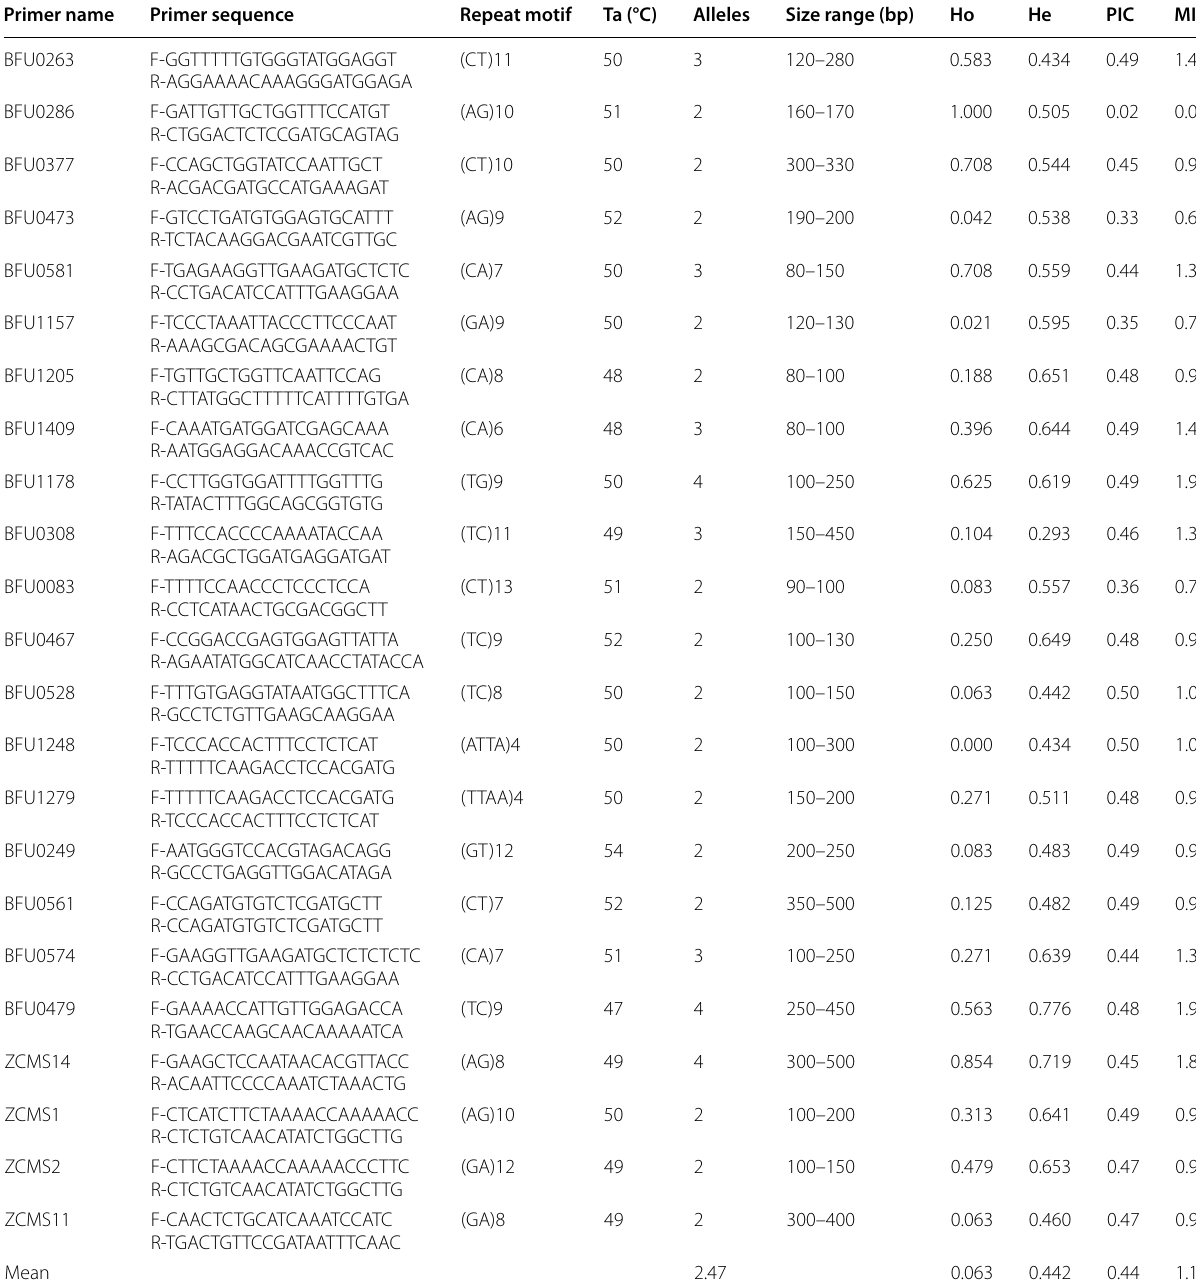
Table 2 SSR primers used in the present study with the details of alleles amplified and diversity indices